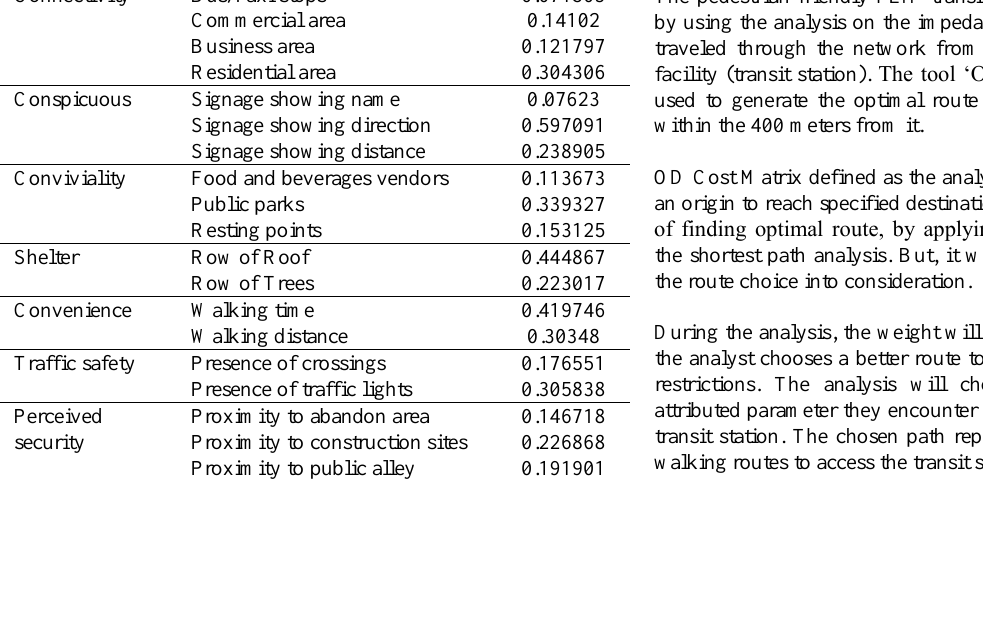
Table 2: Aggregated Priorities for each Sub-criteria